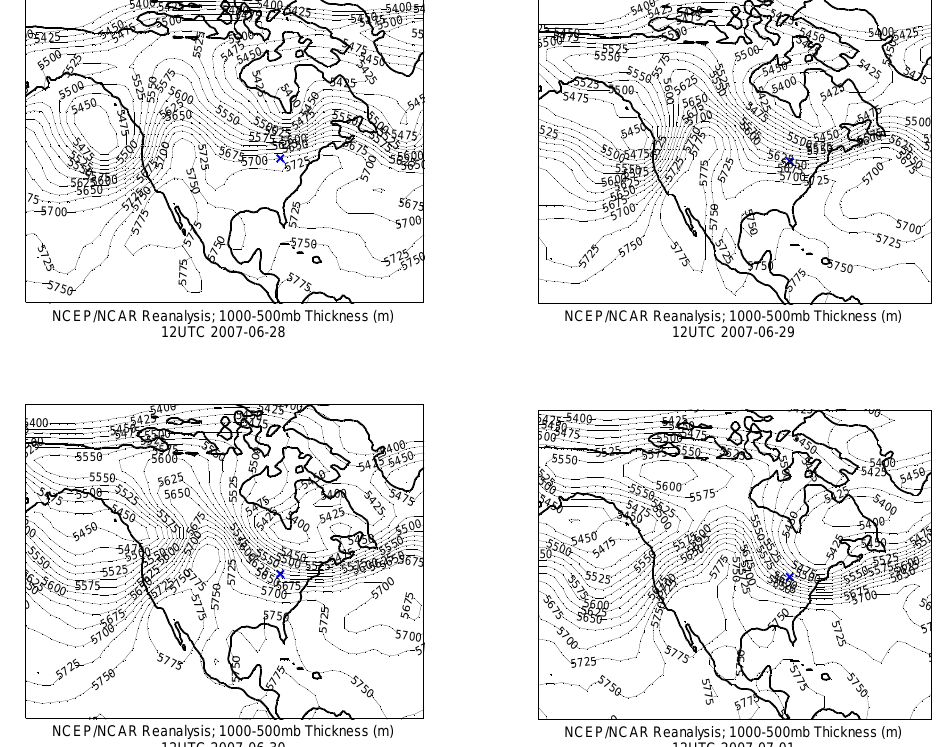
Figure 5: NCEP reanalysis showing 1000–500 hPa thickness in metres for June 28 to July 1, 2007 Fig. 5. NCEP reanalysis showing 1000–500hPa thickness in metres for 28 June to 1 July 2007 at 12:00UTC. The location of the Harrow site is shown by a blue cross. at 12 UTC. The location of the Harrow site is shown by a blue cross.